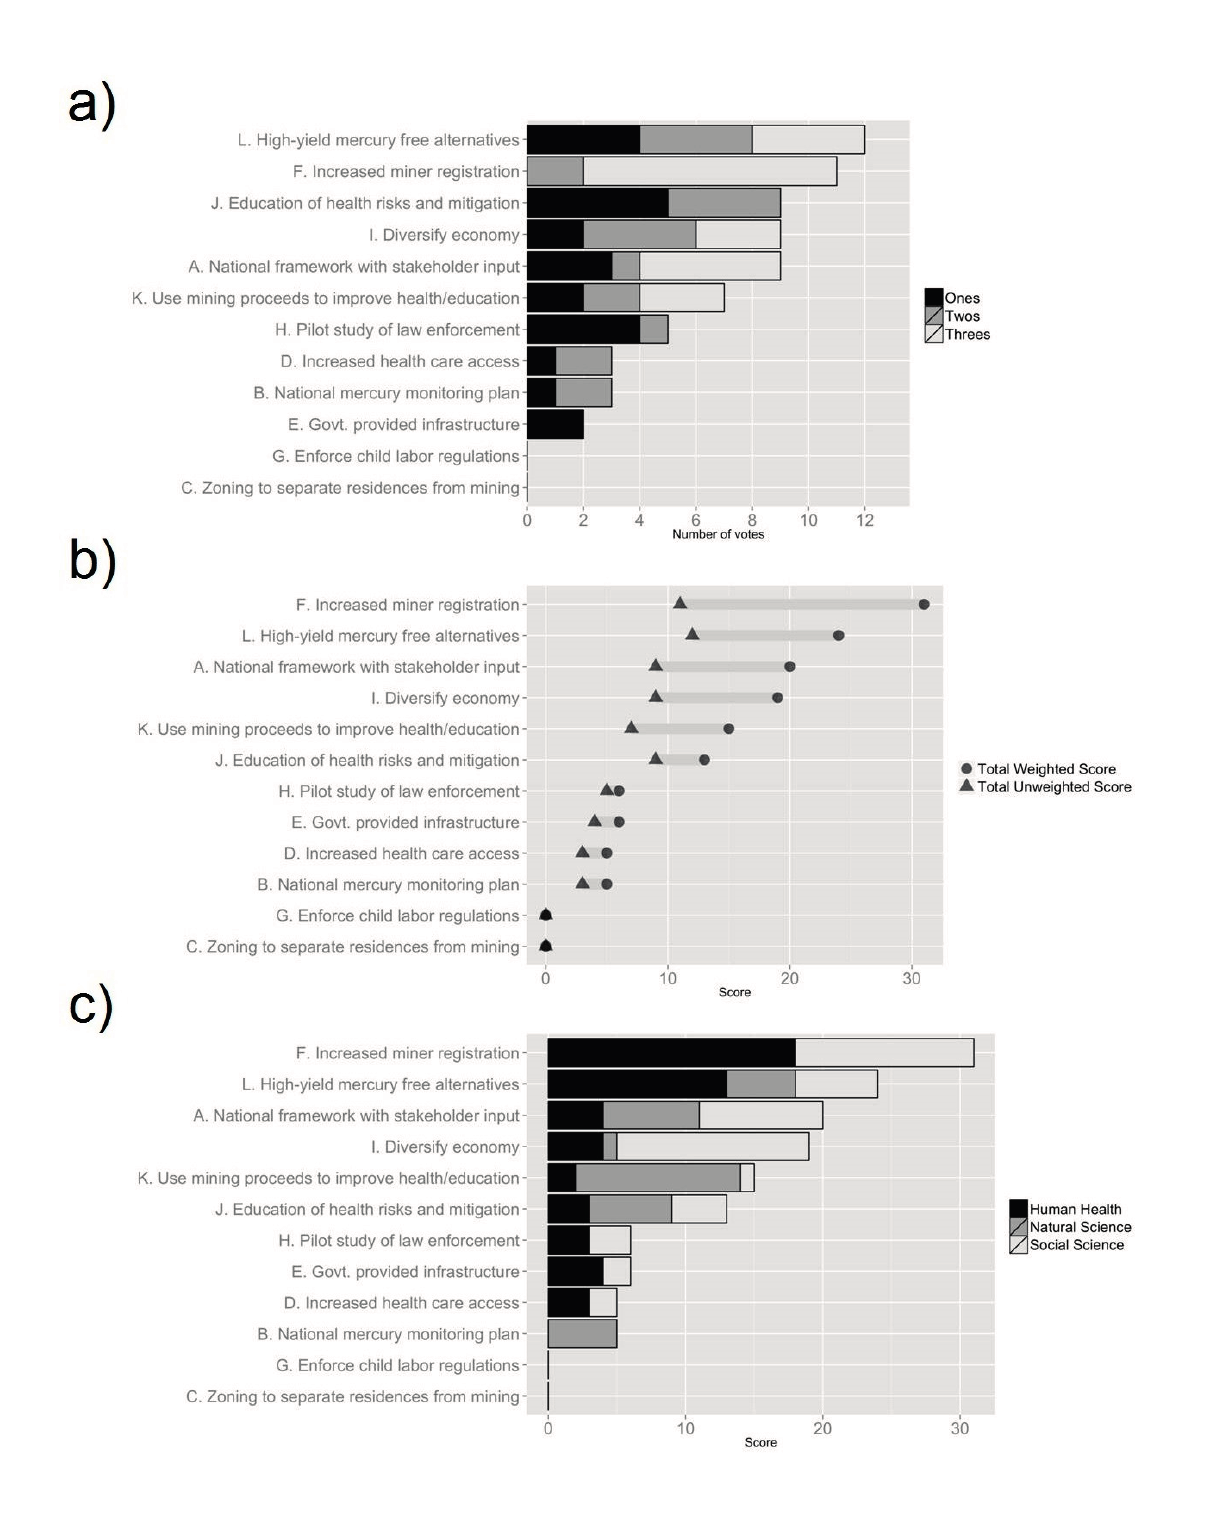
Figure 4. Results from sticky note exercise used to prioritize response options, conducted among academics (n = 27) in April 2014. ( a ) Number of votes for each option; ( b ) Weighted versus unweighted scores for each option; ( c ) Weighted scores for each option, grouped by